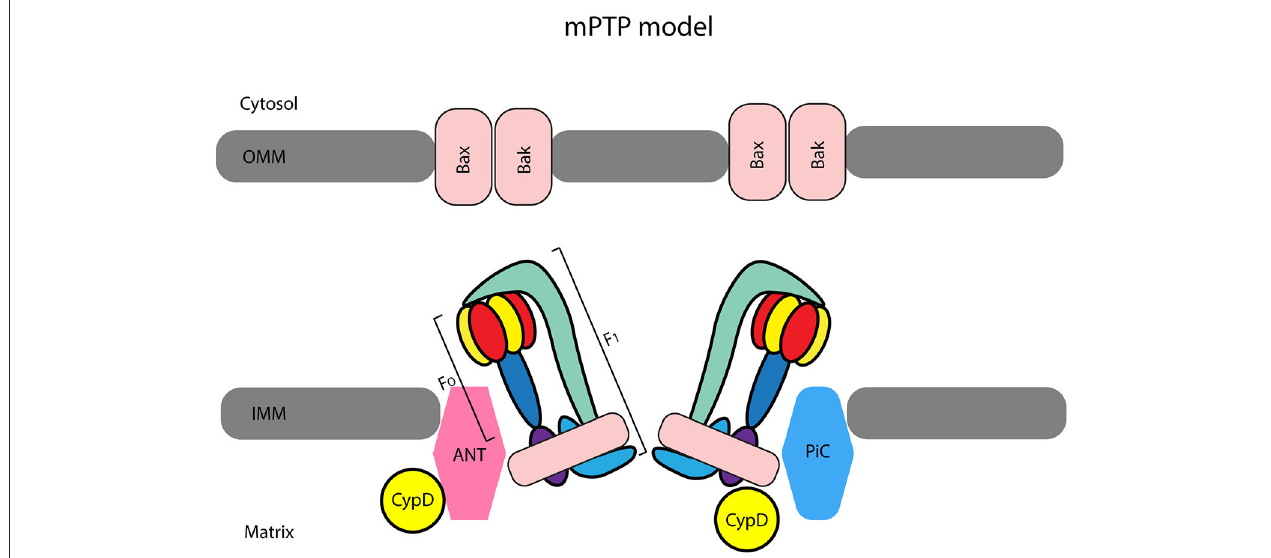
FIGURE 1 | The most accepted model considers ATP synthase subunits as central elements of the mitochondrial permeability transition pore (mPTP). Indeed, the F1FO ATP synthase has been suggested by Bernardi et al. (2015) to be a pore component for the inner mitochondrial membrane (IMM) forming a unit of the mPTP. It has been suggested that adenine nucleotide translocase (ANT) and cyclophilin-D (CypD), together with mitochondrial phosphate carrier (PiC) form a complex that acts as pore regulator. The pro-apoptotic proteins Bax/Bak located in the outer mitochondrial membrane (OMM) favor swelling and subsequently, mitochondria rupture once the IMM complex opens ( Kwong and Molkentin,